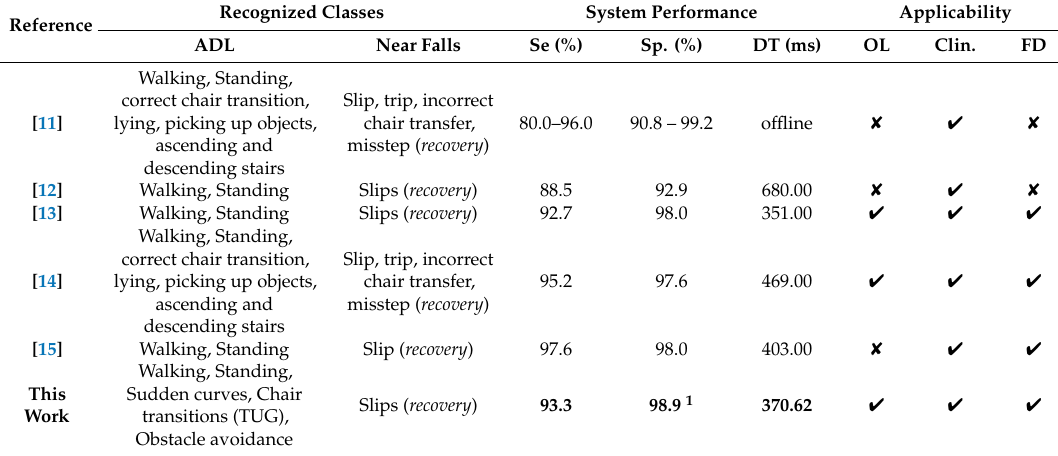
Table 4. Comparison of proposed architecture’s